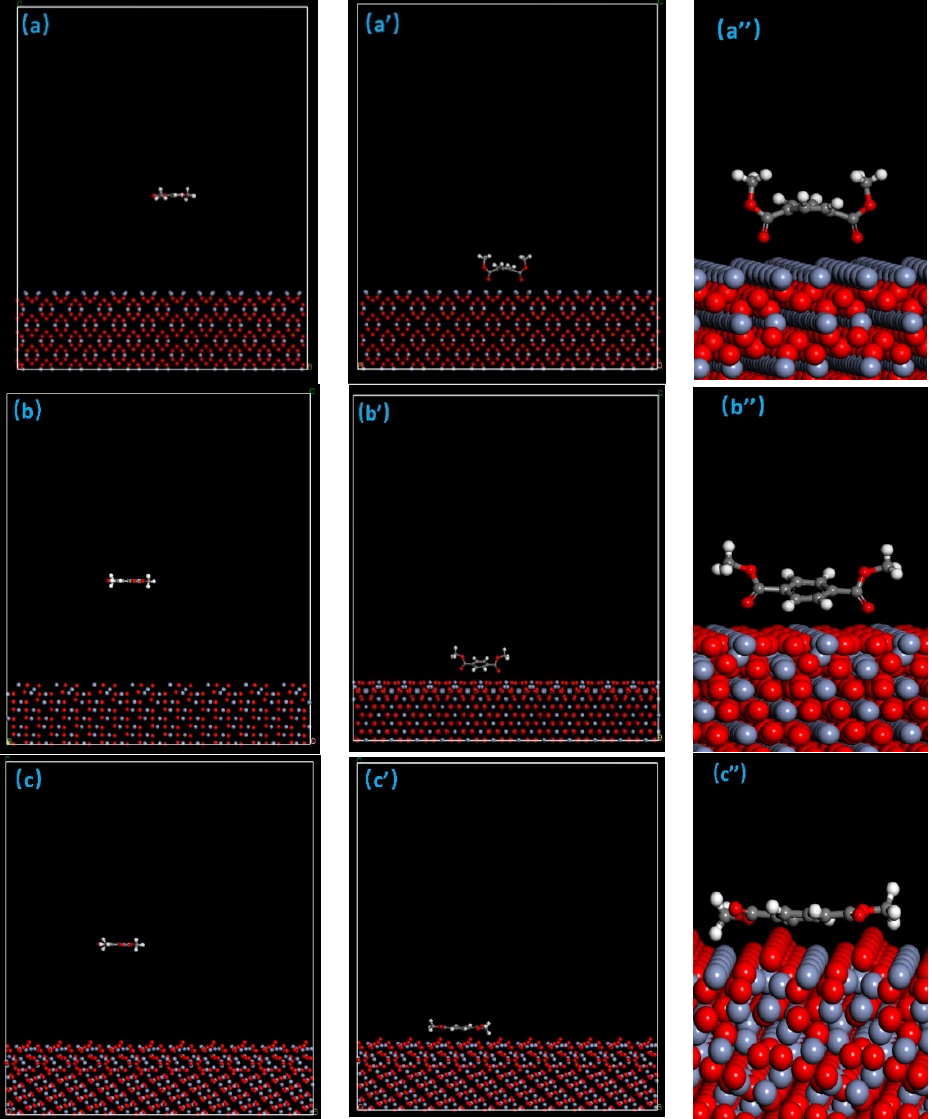
Figure 11. The initial and final configurations of the Cr 2 O 3 (110) ( a , a’ , a” ) surface, Cr 2 O 3 (200) ( b , b’ , b” ) surface and Cr 2 O 3 (211) ( c , c’ , c” ) surface interacting with PET molecules (white is H atom, red is O atom, gray is C